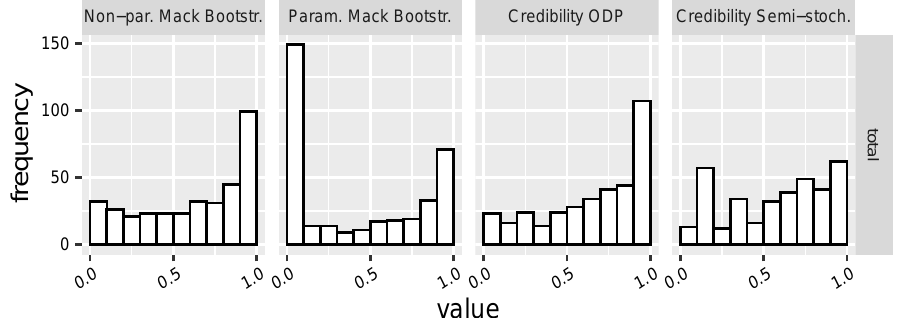
Figure 2. PIT histograms corresponding to the four reserving models and based on all business lines combined.